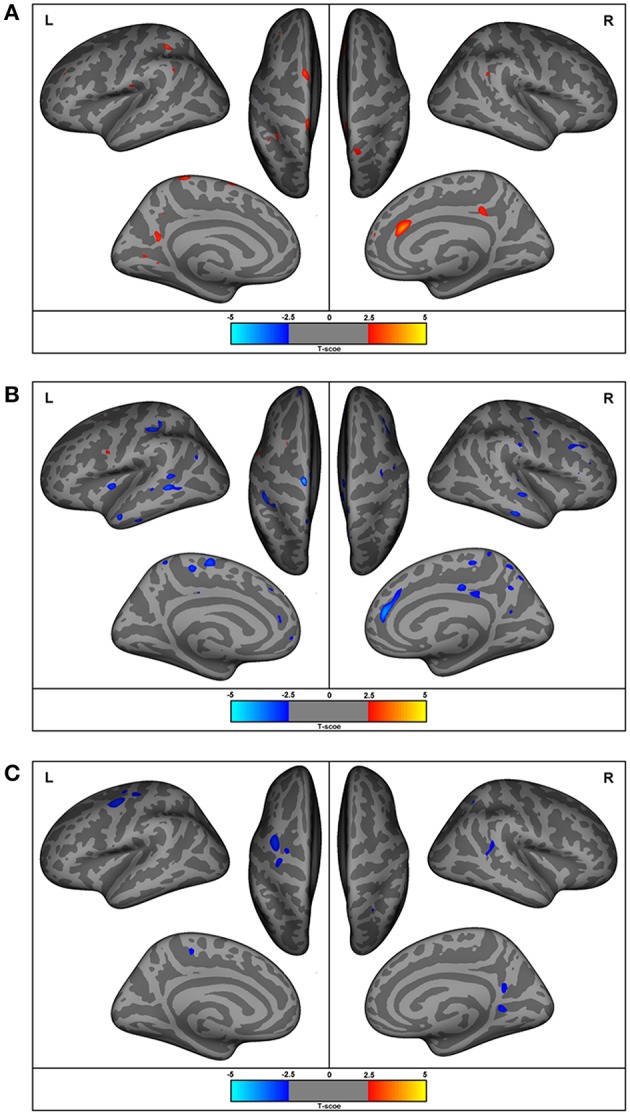
Regions with differences in cortical thickness, surface areas, and gyrification. The most significant clusters for group analysis using a GLM vertex-wise approach, between control and autism groups for left and right hemispheres. In red are areas of decreased and in blue are areas of increased values in patients with autism. All results were corrected for multiple comparisons (Cluster-based correction). (A) ASD presented decreased (in red) cortical thickness in the right cingulate, precentral, superior frontal, superior, and inferior parietal regions. In the left hemisphere, decreased cortical thickness was observed in the supramarginal, superior parietal, paracentral, precuneus, superior, and middle frontal and lingual gyrus, and increased thickness in the postcentral area. (B) Increased surface areas in the superior and middle frontal and precuneus (coinciding with the regions with reduced cortical thickness), as well as in the pre- and post-central, orbitofrontal, posterior cingulate, inferior parietal, temporal lobe (superior, middle, inferior temporal), and insular regions in ASD. (C) Increased gyrification in the lingual, precuneus, superior temporal sulcus, and superior parietal areas in the right hemisphere and the precentral and paracentral areas of the left hemisphere.